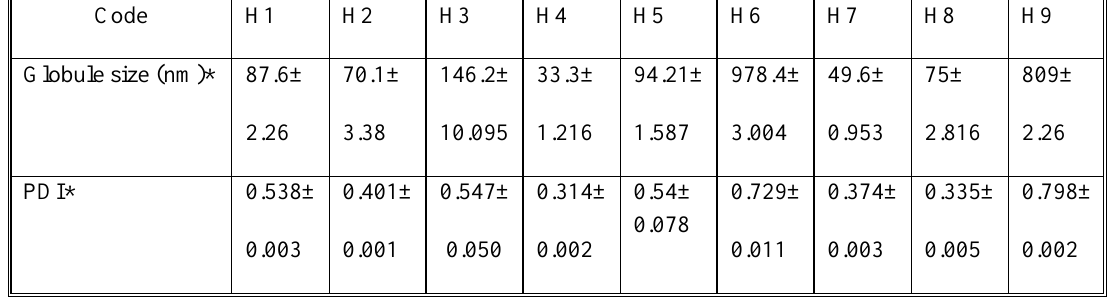
Table 2. The particle size and PDI results of felodipine LPHNs formulations (H1-H9)